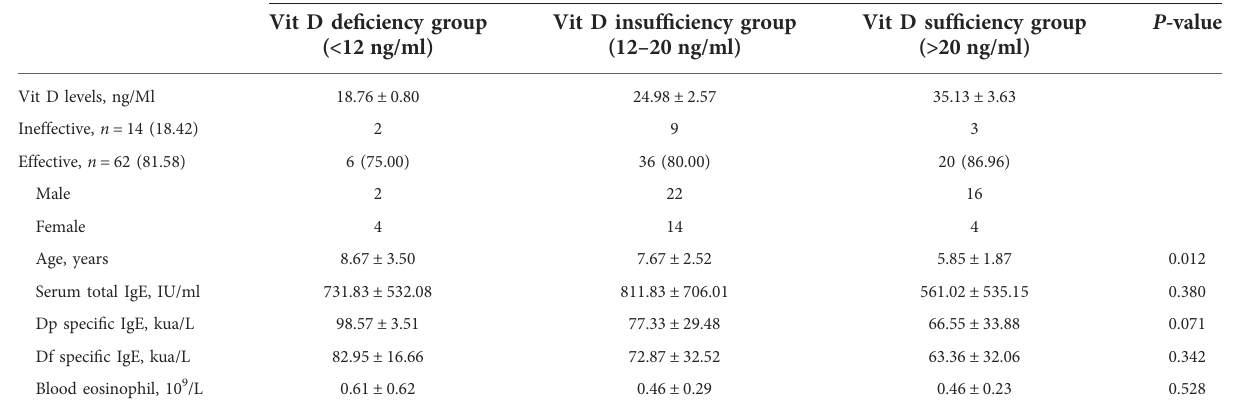
TABLE 1 Demographic data of the study